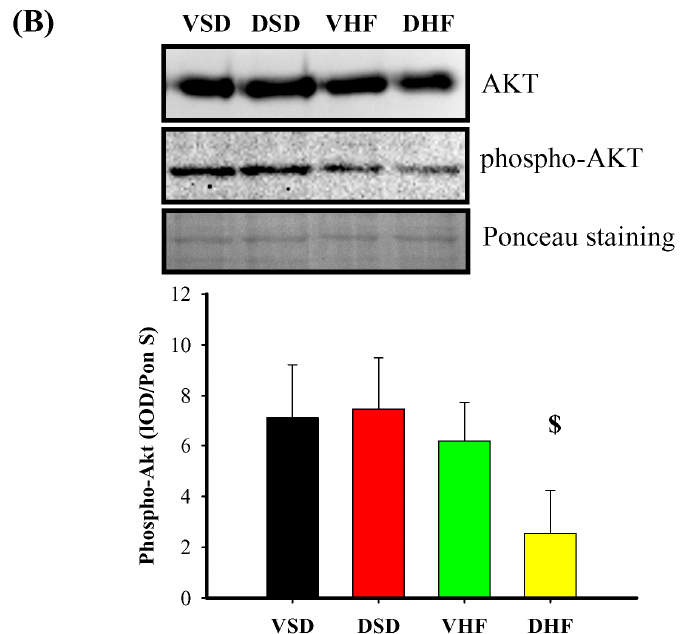
Figure 5. Gastrocnemius muscle mRNA transcript and phopho-AKT protein levels: ( A ) gastrocnemius mRNA transcript levels; and ( B ) gastrocnemius phosphor-AKT protein levels. The red dotted line represented that the relative gene expression was 1 when compared to VSD group. IR, insulin receptor; IGF-1r, insulin-like growth factor 1 receptor; GLUT-4, glucose transporter type 4; IRS-1, insulin receptor substrate 1. Data were compared by two-way ANOVA with post hoc least significant difference tests. * vs. VSD, p < 0.05; $, DSD vs. DHF , p < 0.05; #, VHF vs. DHF, p < 0.05.